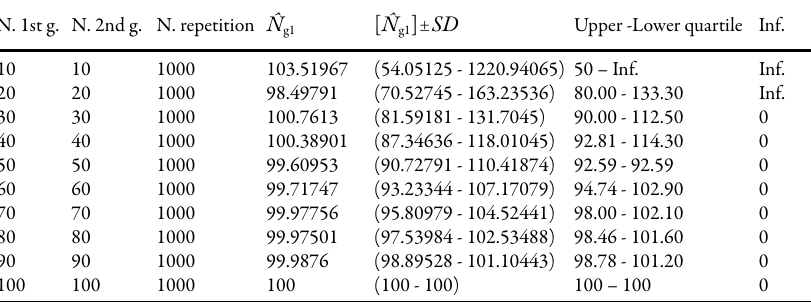
Table 1. The three statistics of experiment 1 of the virtual DNA data by simulation. The number of sampling from first generation is ‘N. 1st g.’. The number of sampling from second generation is ‘N. 2nd g.’. The number of repetitions of the simulation is ‘N. repetition’. The mean value of the estimated effective population size of the first generation (the first statistic) is  g1 . The standard deviation of  g1 (the second statistic) is [  g1 ]  SD. The upper quartile and lower quartile of the estimated effective population size of the first generation (the third statistic) is ‘Upper – Lower quartile’. If we could not measure  g1 after 1000 times, we denoted the situation as ‘Inf.’, which is the abbreviated form of Infinite (i.e.